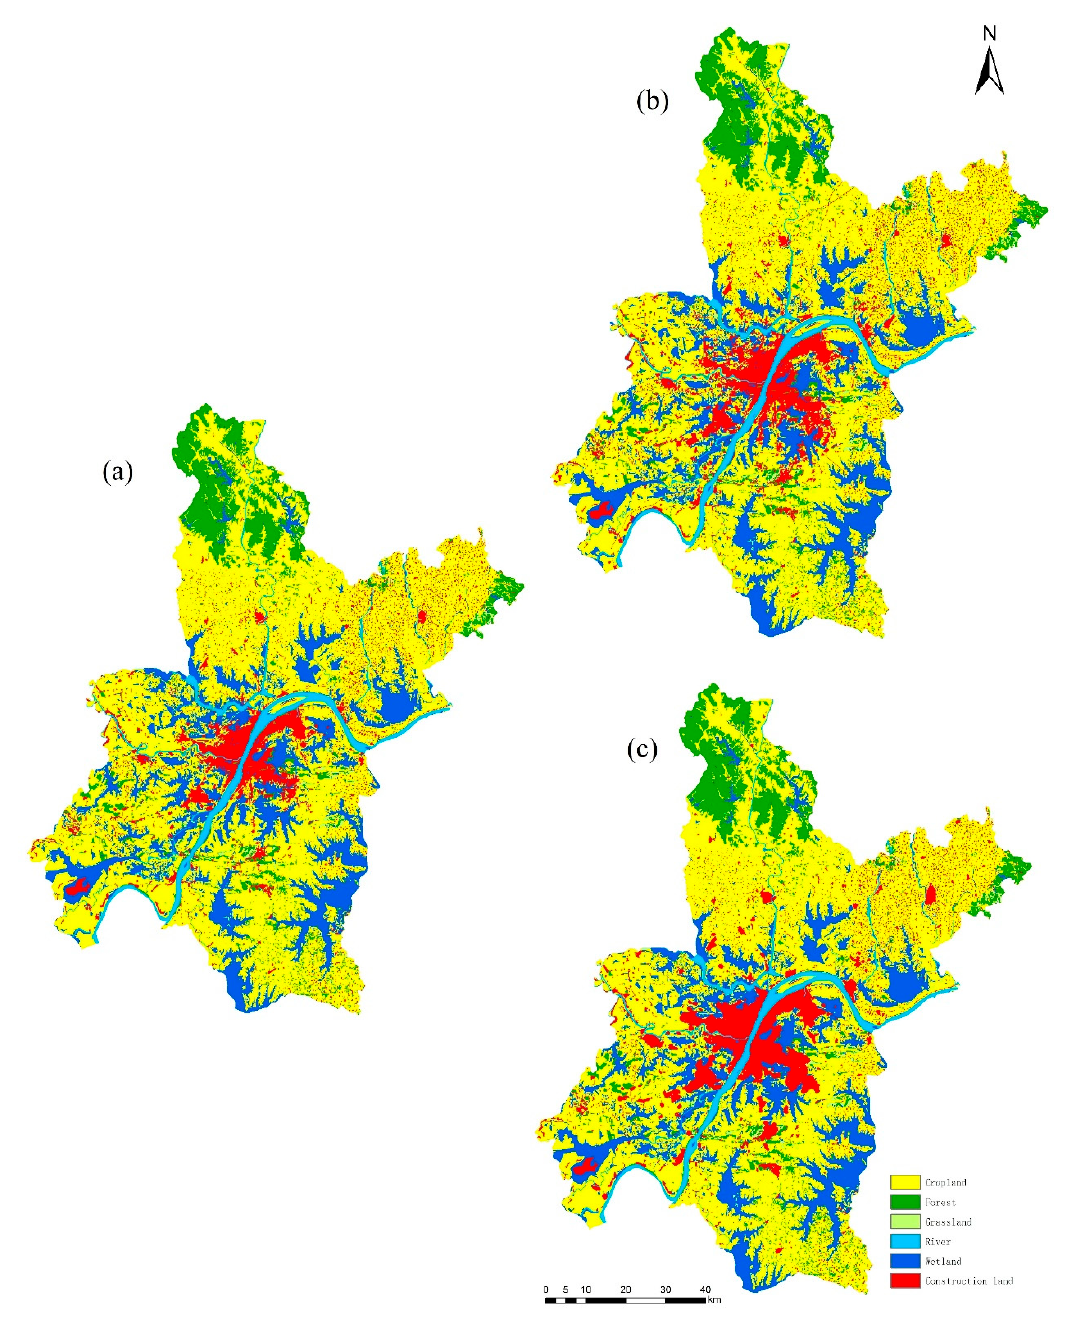
Figure 2. The land use map of the study area in the observed 2000 ( a ), 2013 ( b ) and the simulated results ( c ). Table 5. Kappa simulation score for the calibration results. Cropland Forest Grassland Wetland Construction land